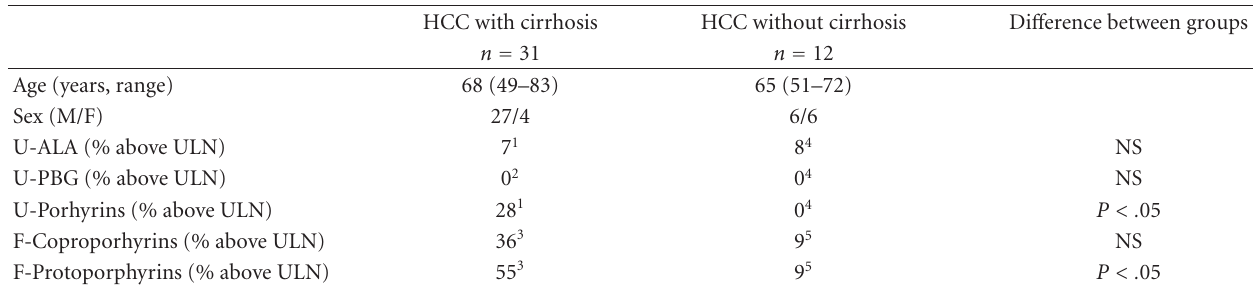
Table 3: Frequency of elevated urinary and/or faecal porphyrins in 43 patients with hepatocellular cancer (HCC), where presence of cirrhosis could be established. In each column is given the proportion (%) of evaluable patients with concentrations above the laboratory reference limit (Upper limit of normal, ULN). ALA : aminolevulinic acid; PBG : porphobilinogen; NS : non